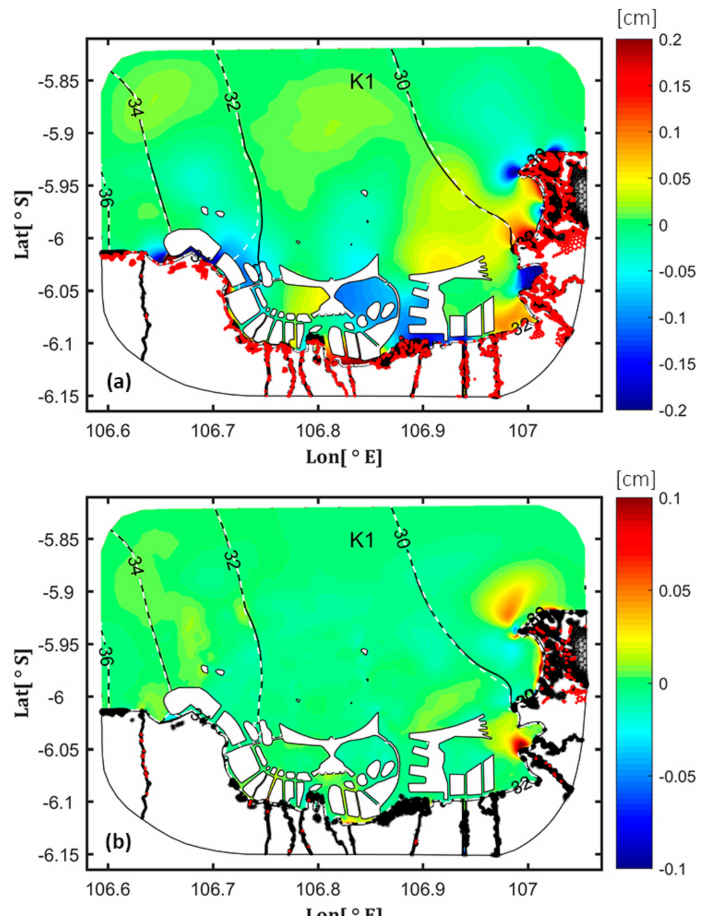
Figure 12. Changes in tidal amplitudes (cm) and inundation areas (red dots) in Jakarta Bay: ( a ) K1 tidal component between scenario 4b and scenario 1 and ( b ) K1 tidal component between scenario 3a and scenario 1. Color contours indicate the changes in amplitude (cm), and the black / white dashed lines indicate the phase